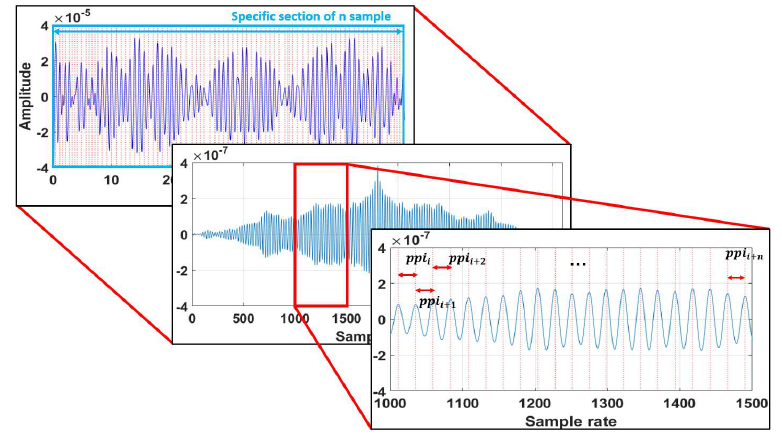
Figure 13. Peak-to-peak interval calculation of the signal with applied ACF to the pulse wave.